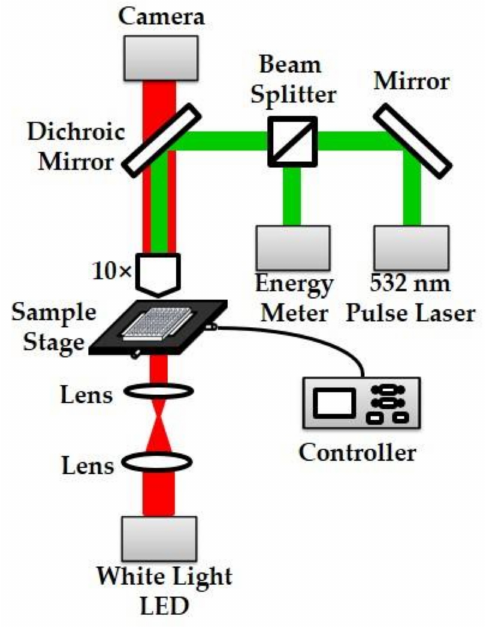
Figure 1. Optical layout of the designed photoporation